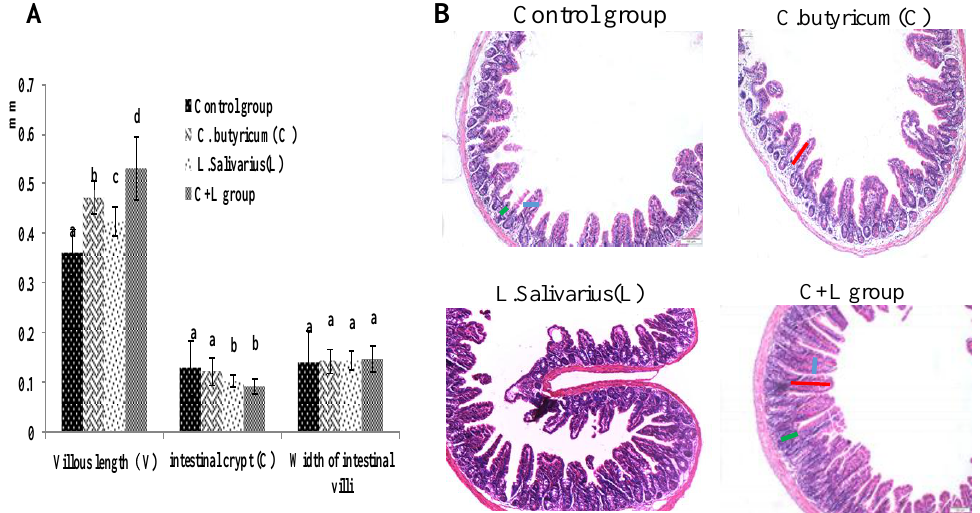
Figure 1. The villous length, intestinal crypt, width of intestinal villi and the ileum slice (HE 10 × 10) in different groups. ( A ) The villous length, intestinal crypt, width of intestinal villi; ( B ) the ileum slice (HE 10 × 10) in control group, L. salivarius group, C. butyricum group and combined treatment group. Red line represents villous length, green line represents intestinal crypt depth, blue line represents villi width. Note: On the column of different letters differed significantly ( p < 0.05), without superscript or marked with the same letter angle has no significant difference ( p >